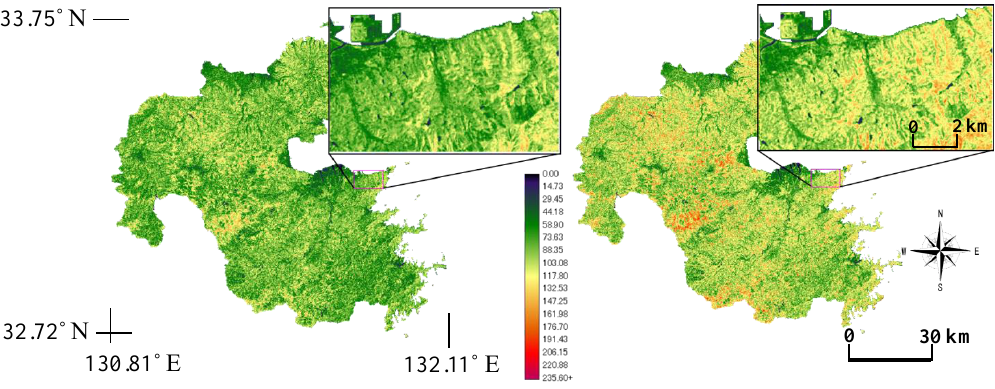
Figure 6. Original near-infrared band (band 4) image ( left ) and IRC corrected image ( right ) over the study